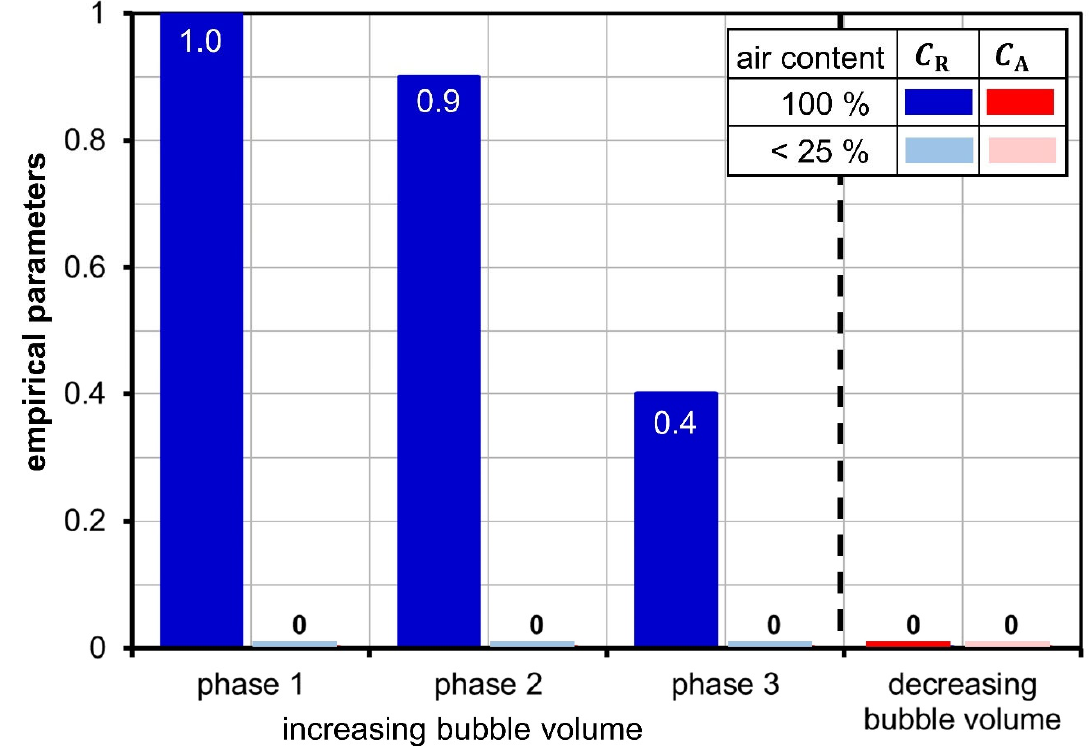
Figure 19. Empirical parameters according to Schneer–Sauer model for bubble growth after initiation of transient radial displacement in relation to volume of dissolved air, fluid: paraffin.